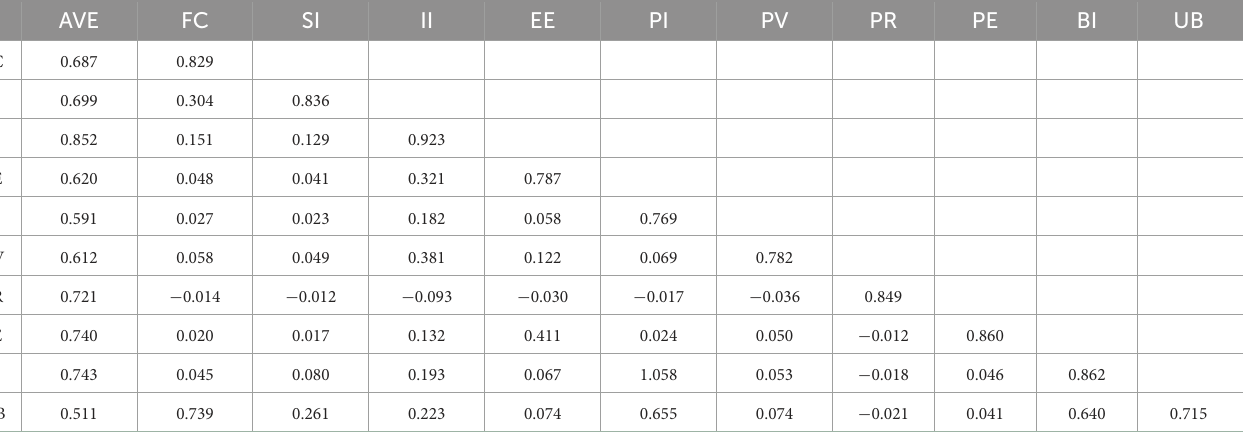
TABLE 3 Discriminant validity of the measurement